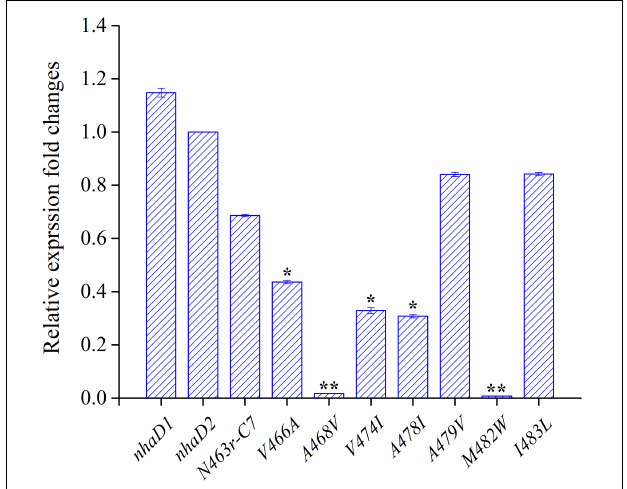
FIGURE 7 | Transcript levels of N463r-C7 mutants determined by qPCR analysis. The relative expression levels for each gene were calculated using the by 2 − (cid:49)(cid:49) Ct with normalization to 16S rRNA genes. The significant differences ( ∗∗ P < 0.001, ∗ P < 0.05, fold change ≥ 2 or fold change ≤ 0.5, Student’s t -test) between the expression levels of mutated genes and nhaD2 are indicated by